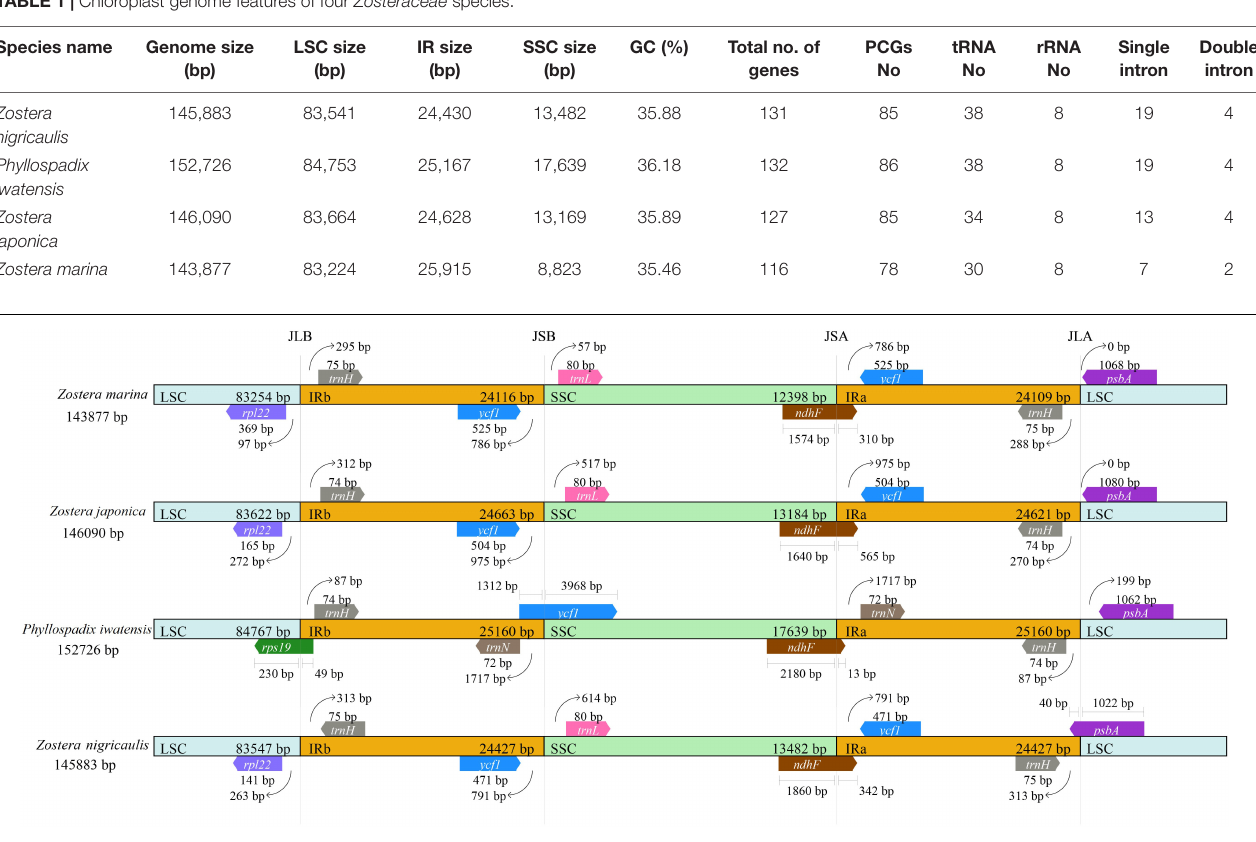
FIGURE 2 | Comparison of the border positions of LSC, SSC, and IR regions in the chloroplast genomes in four Zosteraceae